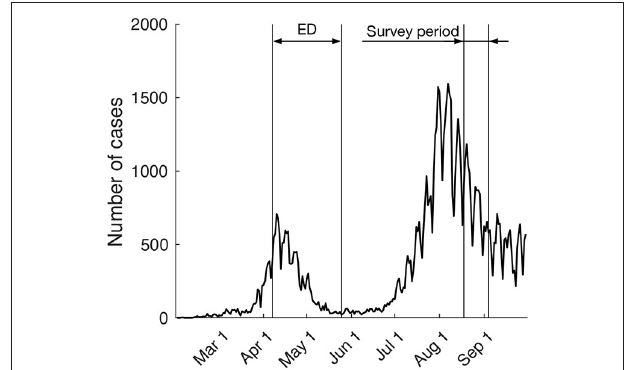
FIGURE 1 | The number of daily COVID-19 cases in Japan. The Japanese government announced the ED requiring people in Tokyo to refrain from unnecessary going-out activities on April 7 and lifted it on May 25. Our online survey was carried out from August 18 to September 4. This survey period was ∼ 3 months after the ED for the first wave of the COVID-19 pandemic in Japan and was conducted during the putative second wave. This plot is based on the data released by the Ministry of Health, Labour, and